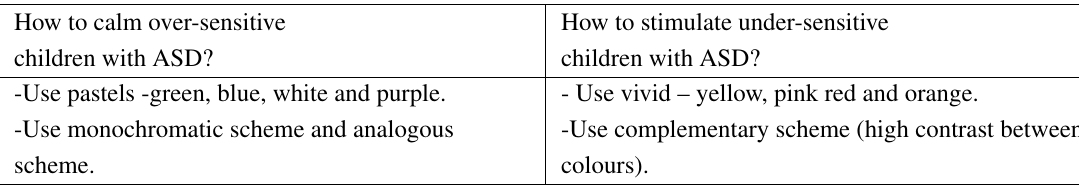
Table 6. How to use colour in creating a specific influence (Wilson, 2006)